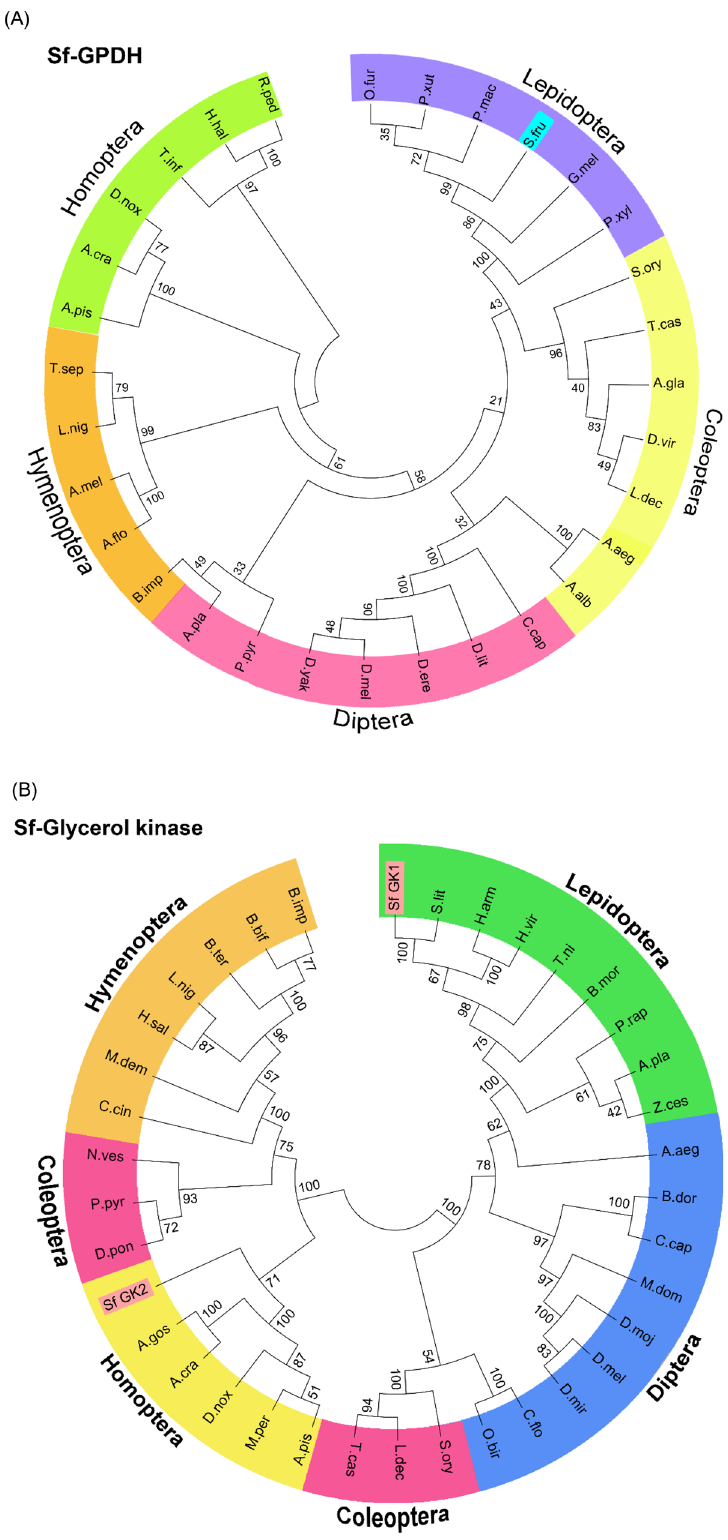
Figure 5. Phylogenetic analysis of glycerol biosynthesis genes including ( A ) glycerol-3-phosphate dehydrogenase (GPDH) and ( B ) two glycerol kinases (GK1 and GK2) of Spodoptera frugiperda with other insect species from different orders. The analysis was performed using MEGA6.06. Each node contains bootstrap value after 1000 replications to support branching and clustering. Accession numbers and the abbreviation explanation are shown in Table